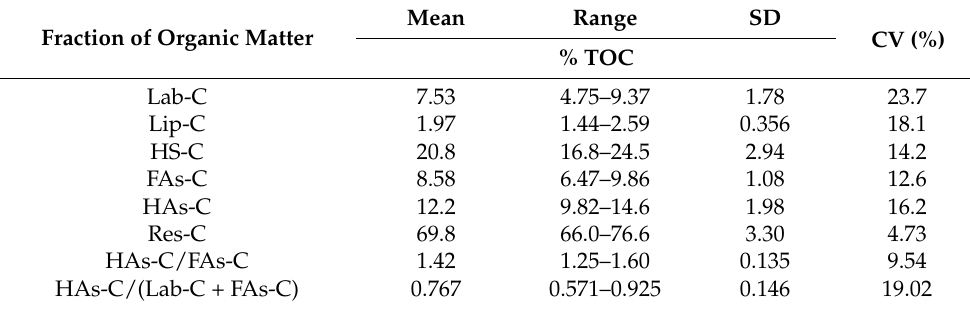
Table 4. Carbon share in organic matter fractions of spent mushroom substrates. Mean Fraction of Organic Matter